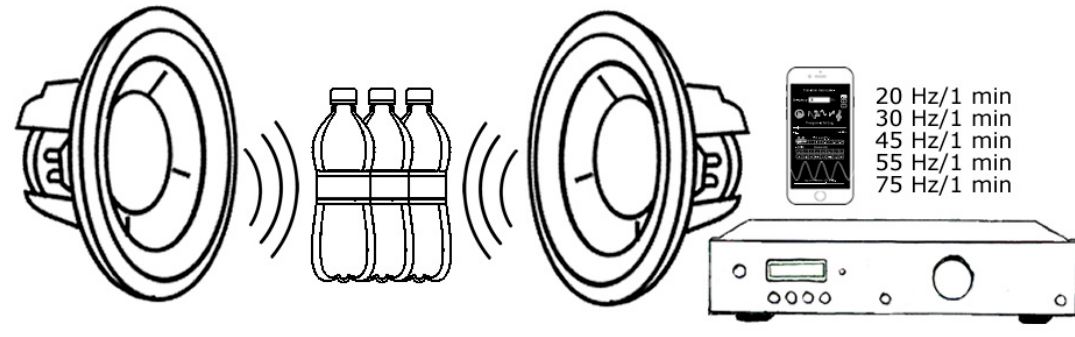
Figure 1. Set up of the application of audible sound waves to carbonated water samples.